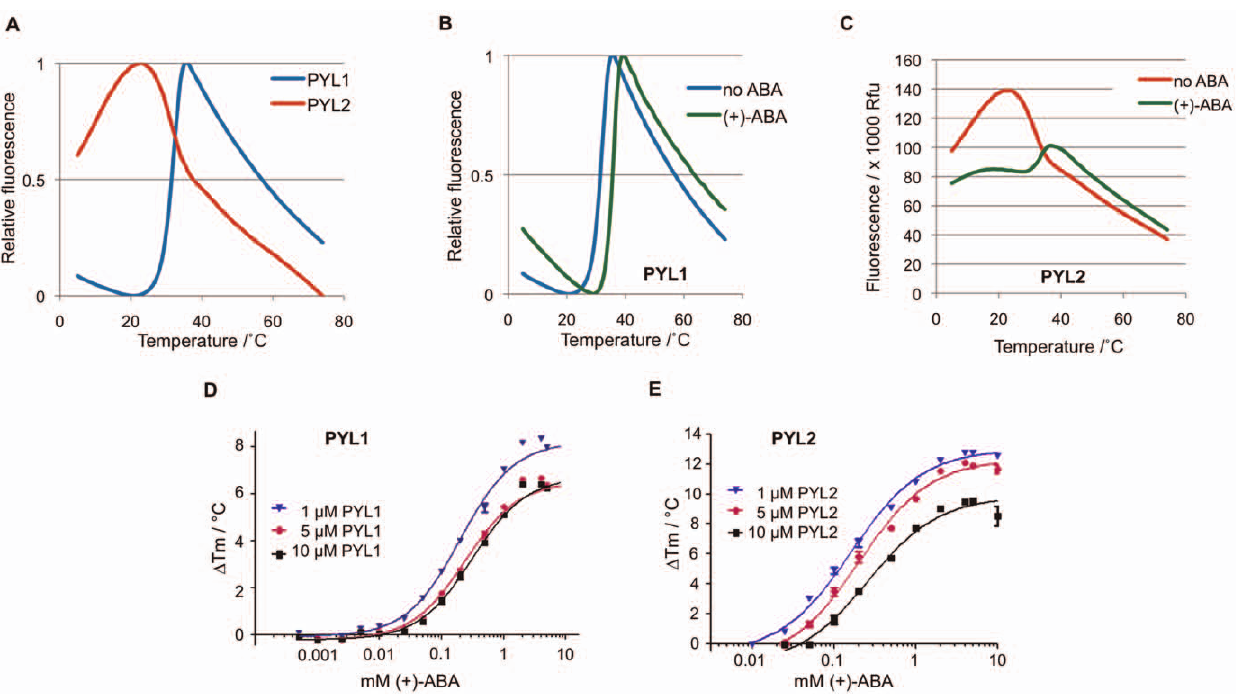
Figure 3. ABA-induced stabilization of PYL1 and PYL2 in a dose-dependent manner. ( A ) Melt curves of apo-PYL1 and -PYL2. ( B ) Melt profile of PYL1 in the presence of high concentration of ( + )-ABA. Shift in the melt curve upon addition of 500 m M of ( + )-ABA suggests a stabilization effect due to binding. ( C ) Melting profile of PYL2 in the presence of 25 m M ( + )-ABA. Initial fluorescence was reduced and a two-state transition was observed. ( D + E ) ( + )-ABA/ D Tm dose-response curves for PYL1 ( D ) and PYL2 ( E ).